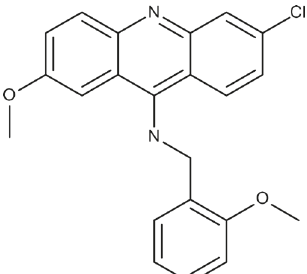
FIGURE 27 - Compound 7r reported in the literature for inhibiting the enzymes VEGFR-2 and